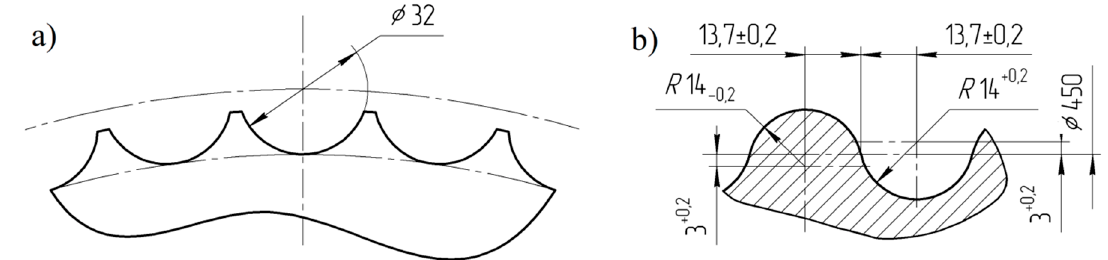
Figure 3. Geometry of moulding cavities on the working surface of rolls used for tests: ( a ) front view and ( b ) cross section through the groove.